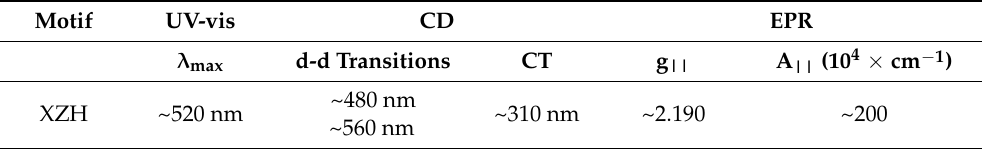
Table 3. Typical spectroscopic features of the ATCUN XZH motif of Cu 2+ complexes